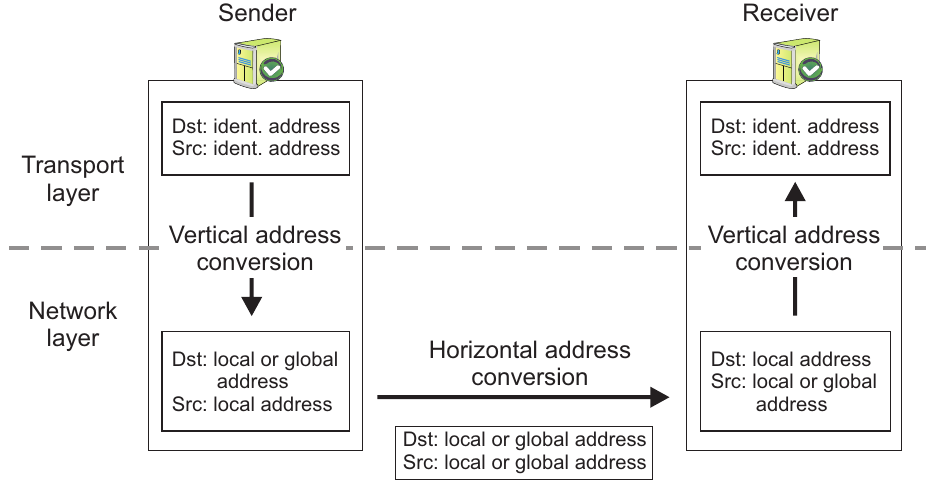
Figure 2. GLI-nodes translate identifier addresses to local or global addresses when handing data from the transport layer to the network layer and vice versa